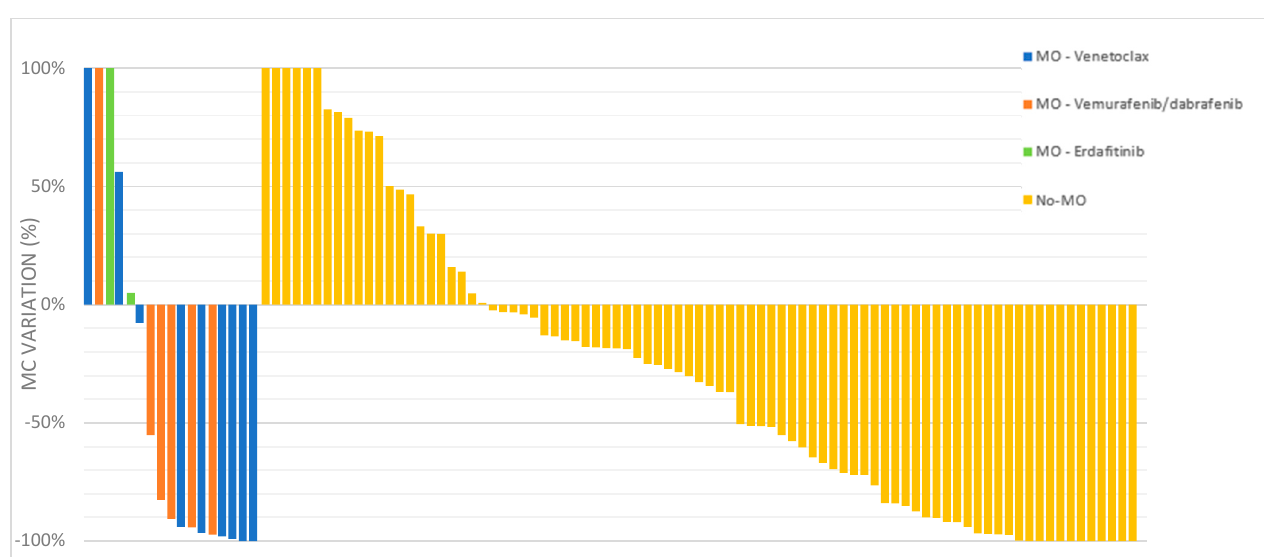
Figure 5. Change in monoclonal component serum measurement according to MO or no MO treatment in patients with R/R MM included in the MM-EP1 study. A cascade plot of the percent change in serum monoclonal component was made as a function of the best treatment response (nadir) achieved during treatment. MC: monoclonal composant, MO: molecularly oriented, VEN: venetoclax, BRAFi: BRAF inhibitor, FGFR3i: FGFR3 inhibitor. Table 3. Details of molecular-oriented patients correlating with response assessment. The median PFS was 9 and 6 months, respectively, in MO and no-MO treated patients (HR = 0.96; CI95 = 0.51–1.78; p = 0.88). Median OS was 26 and 28 months, respectively, in MO and no-MO treated patients (HR = 0.98, CI95 = 0.46–2.12; p = 0.98) (Table 2, Figure 6). At last follow-up, 54 deaths occurred: 8 in the MO-arm and 46 in the no-MO-arm. Causes of death were MM progression ( n = 47), secondary malignancies ( n = 3), COVID-19 ( n = 2),